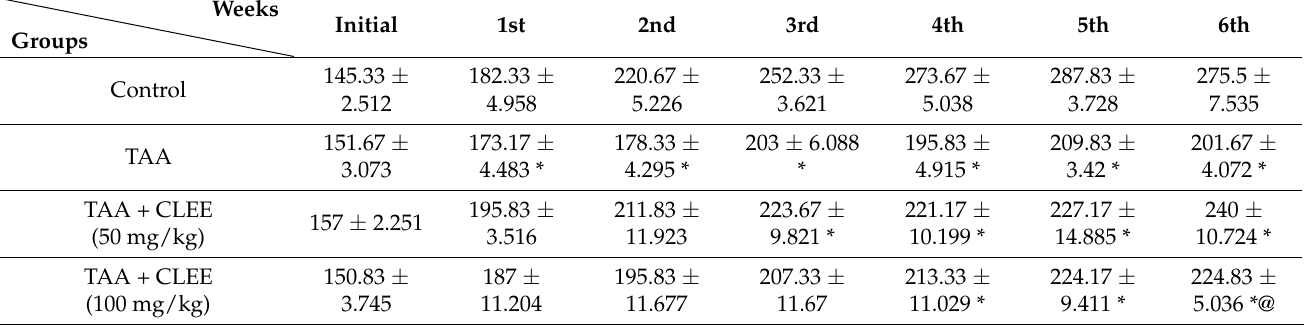
Table 2. Effect of C. laevigatus ethanol extract (CLEE) on body weight of rats administered with